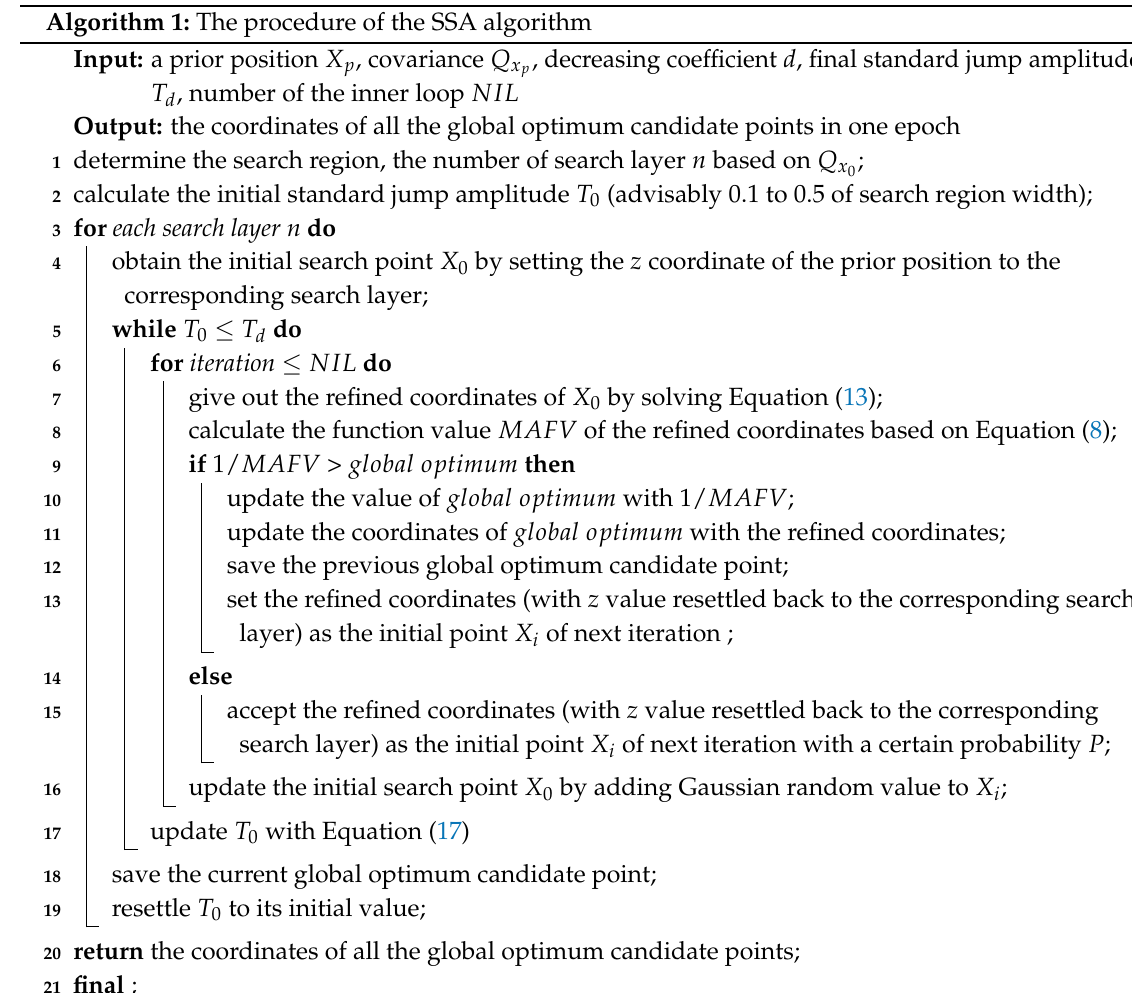
Algorithm 1: The procedure of the SSA